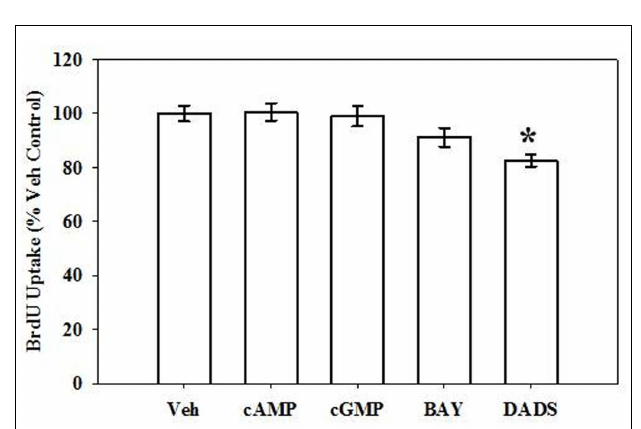
FIGURE 1 | Effects of cyclic nucleotide or Cx43 stimulation on VSMC proliferation. (A) In rat primaryVSMCs in the presence of 10% serum for 72h and using the MTT assay, 8Br-cAMP (100 µ M), the sGC stimulator BAY (100nM) or the garlic-derived Cx inducer DADS (50 µ M) significantly reduced rat primaryVSMC numbers compared with vehicle controls. Data are mean ± SEM with an n = 6. (B) Using hemocytometry after 72h, both 8Br-cAMP and BAY significantly